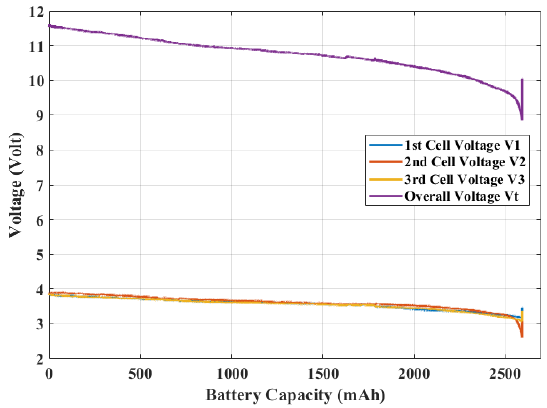
Figure 16. Battery capacity curve.